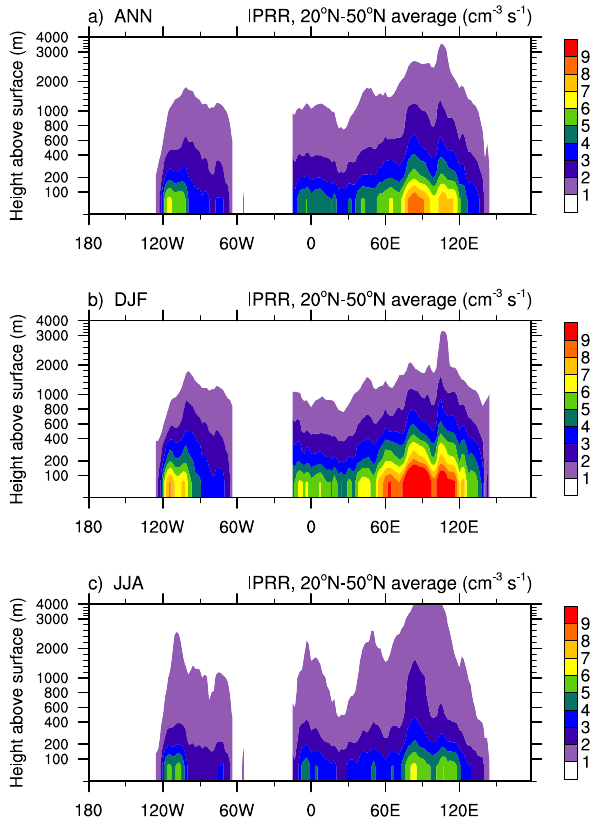
Fig. 13. Height-longitude cross section of the 20 ◦ N–50 ◦ N mean ionization rate over land caused by radon and its progeny. The re- sults are obtained using the newly merged radon emission map.